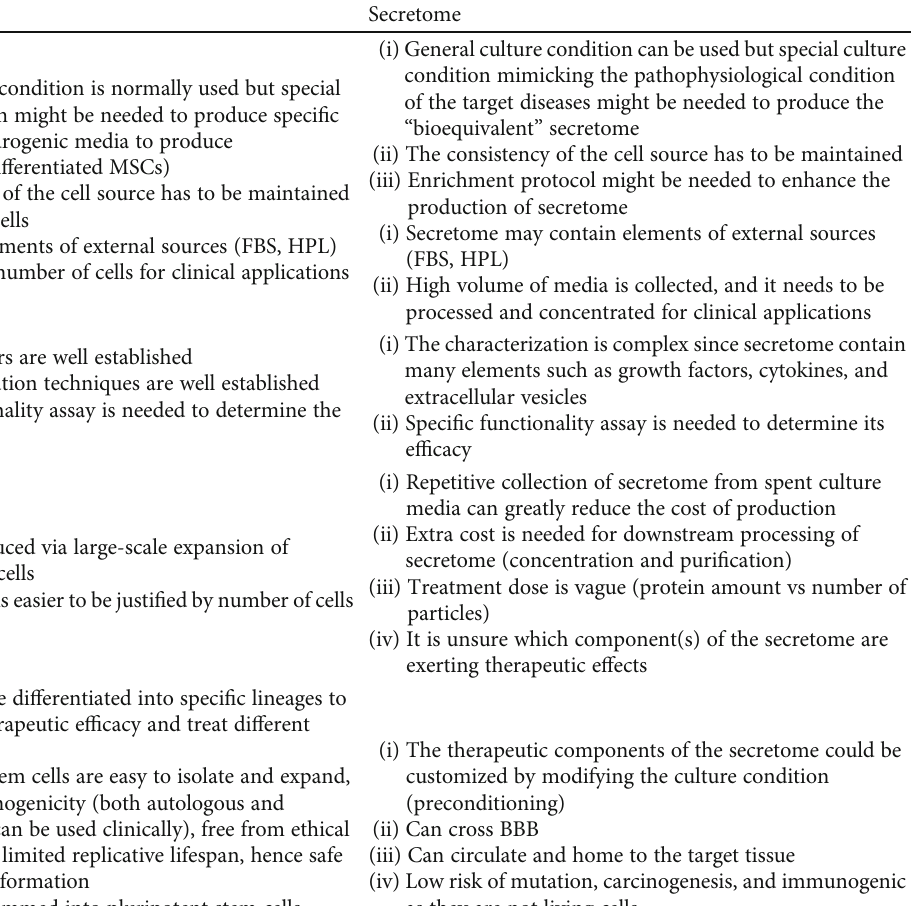
Table 4: Comparison between stem cell and